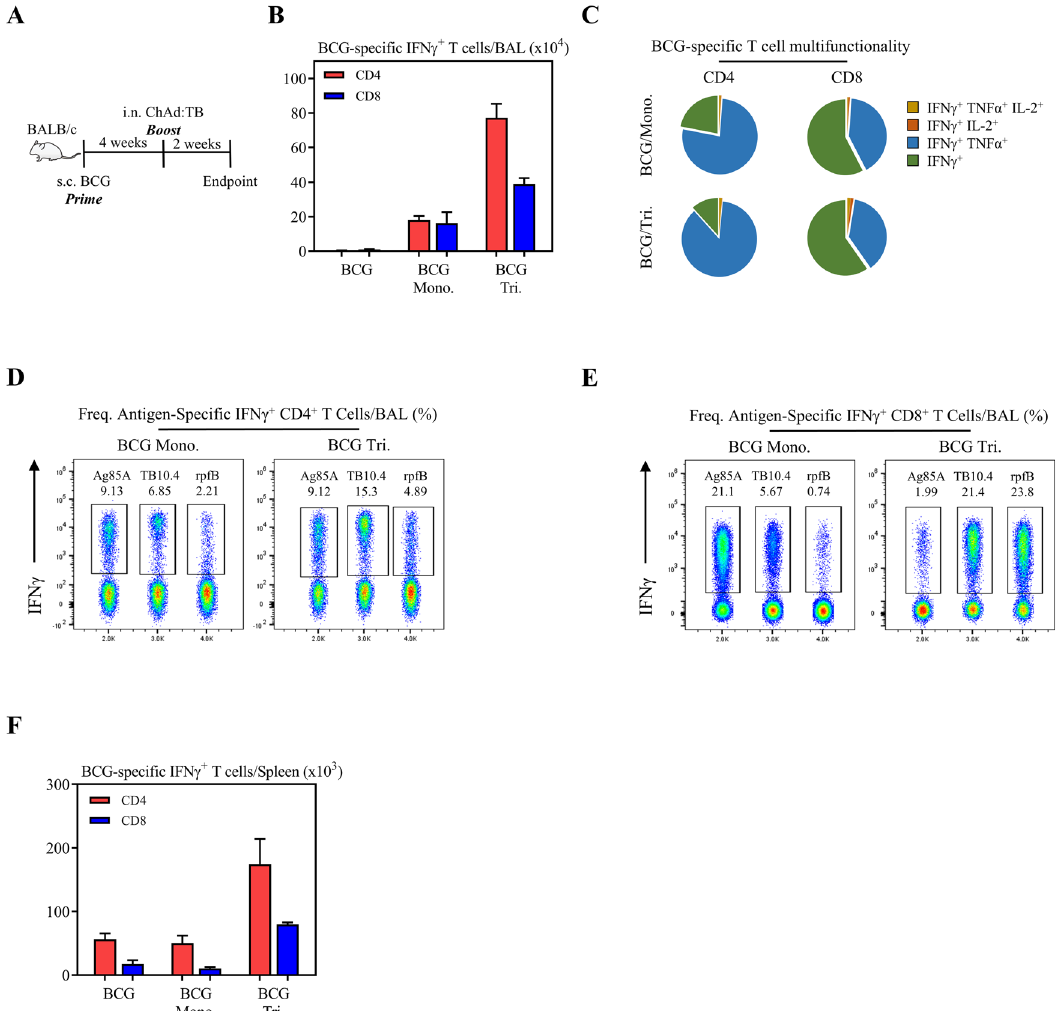
Fig. 2 Immunogenicity of a multivalent ChAd:TB vaccine in BCG-primed animals. A Experimental schema. B Bar graphs depicting absolute numbers of either CD4 + (red) or CD8 + (blue) T-cell responses in the BAL, as measured by expression of IFN γ following ex vivo stimulation with crude BCG/culture fi ltrate. C Pie charts depicting the functionality (IFN γ , TNF α , and/or IL-2) of CD8 + or CD4 + T cells in the BAL following ex vivo stimulation with crude BCG/culture fi ltrate. D Flow cytometric plots of IFN γ + CD4 + T cells in the BAL from concatenating CD3 + gated cells following ex vivo stimulation with Ag85A, TB10.4, or RpfB whole protein. E Flow cytometric plots of IFN γ + CD8 + T cells in the BAL from concatenating CD3 + gated cells following ex vivo stimulation with Ag85A, TB10.4, or RpfB whole protein. F Bar graphs depicting absolute numbers of either CD4 + (red) or CD8 + (blue) T-cell responses in the spleen, as measured by expression of IFN γ following ex vivo stimulation with crude BCG/culture fi ltrate. Data presented in ( B , F ) represent mean ± SEM of n = 3 mice/group. Data are representative of one independent